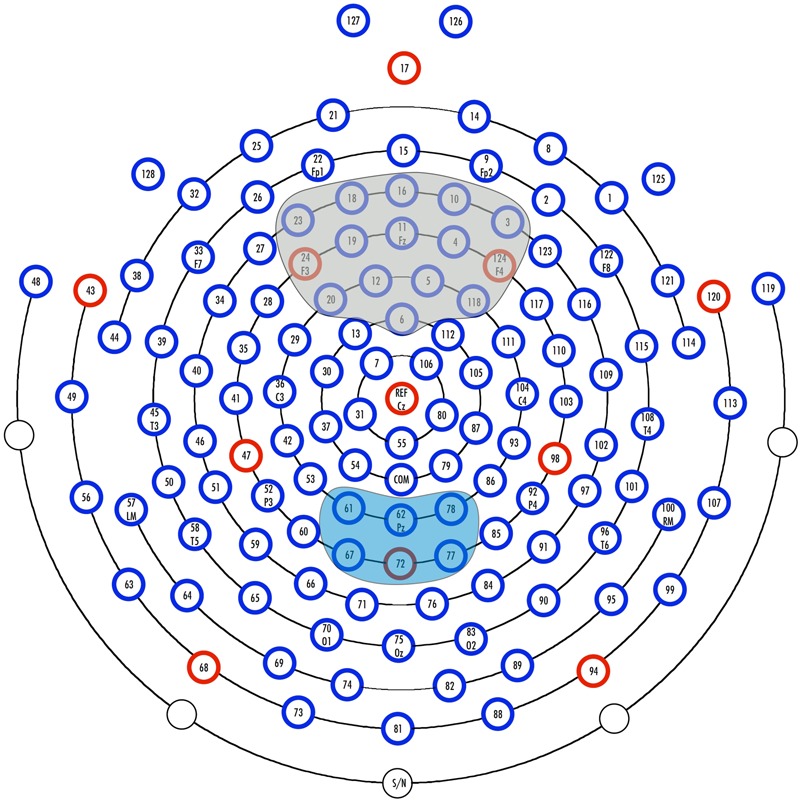
Illustration of the 128-channel system (Electrical Geodesics, Inc.) and the examined regions of interest. The electrodes included in the parietal ROI of the conflict slow potential (cSP) are marked in blue. Electrodes included in the fronto-central ROI of the N1 and N2 are gray.